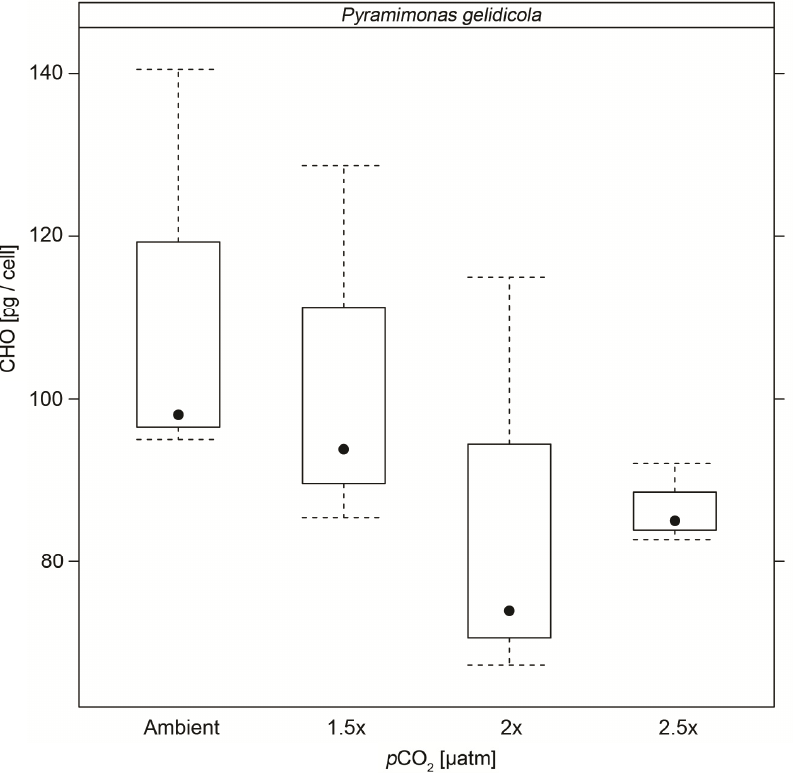
concentrations. 2